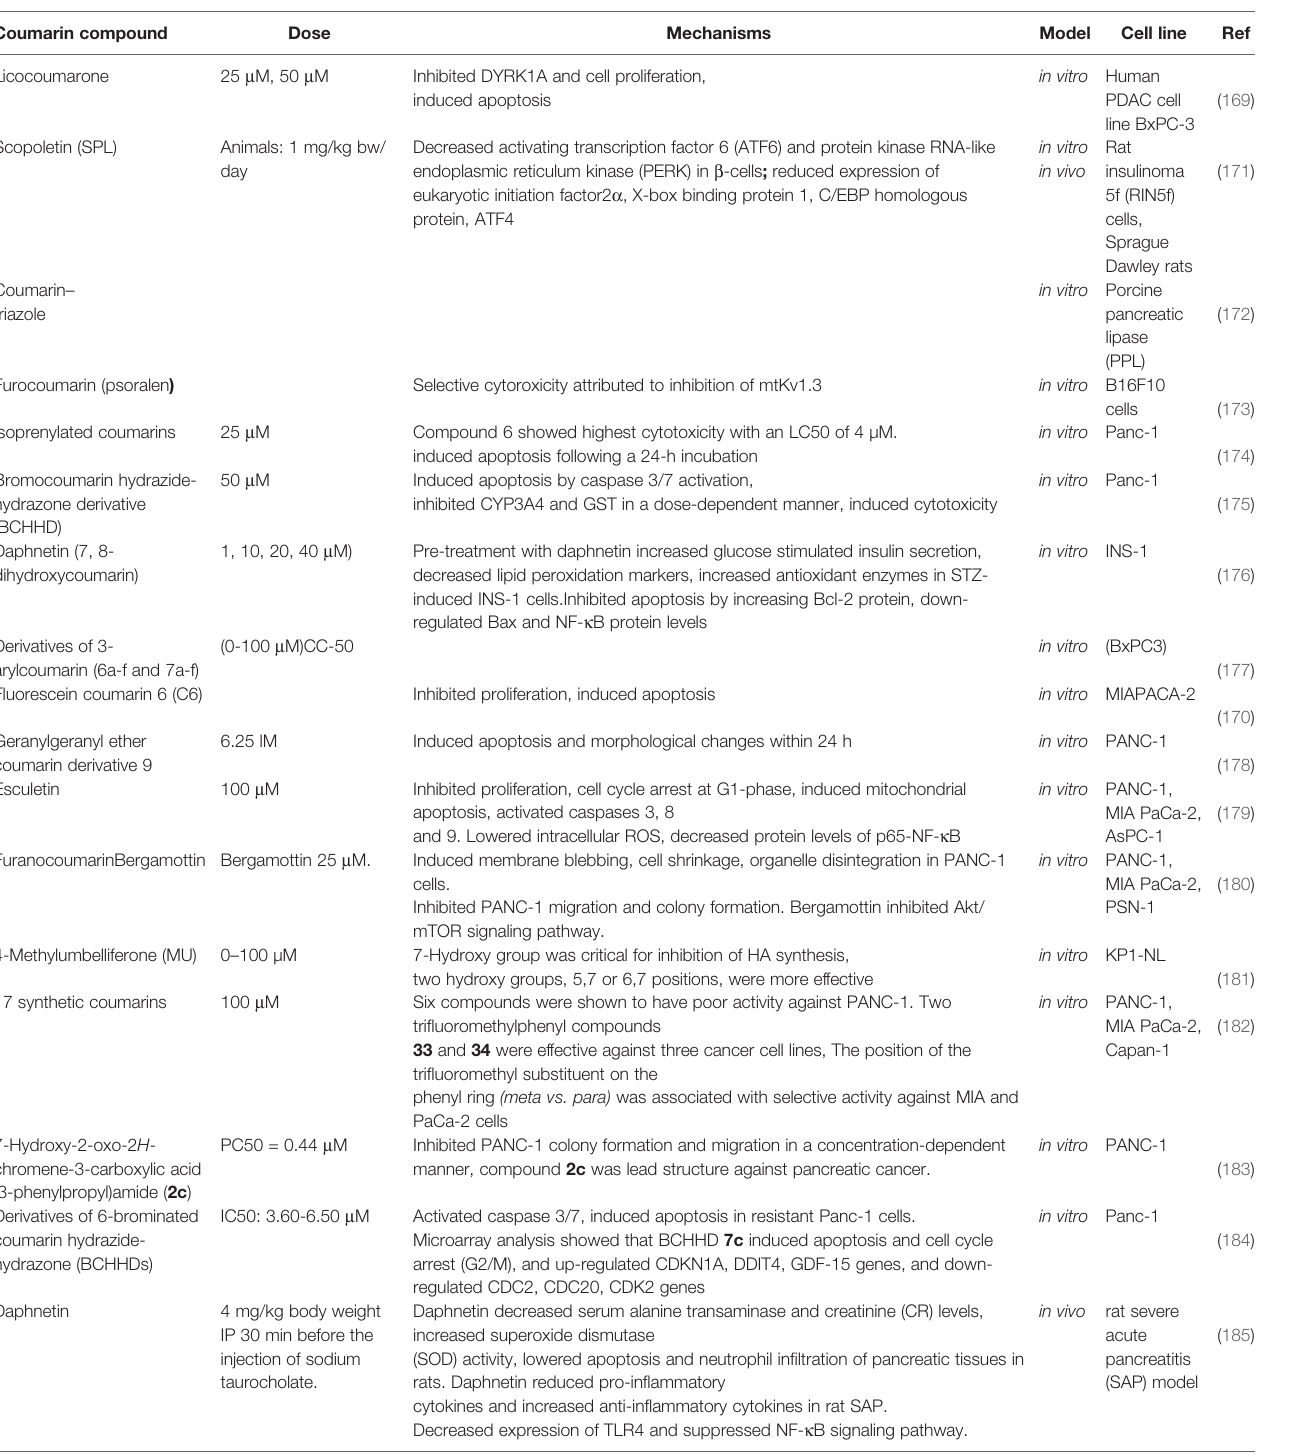
TABLE 3 | Anti-pancreatic cancer effects of